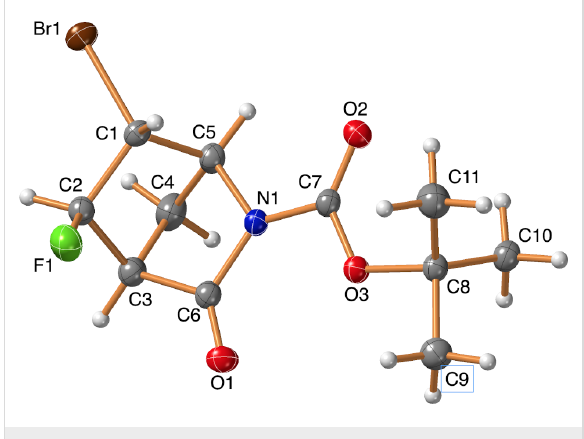
Figure 2: Crystal structure of the product ( rac ) - 15a .